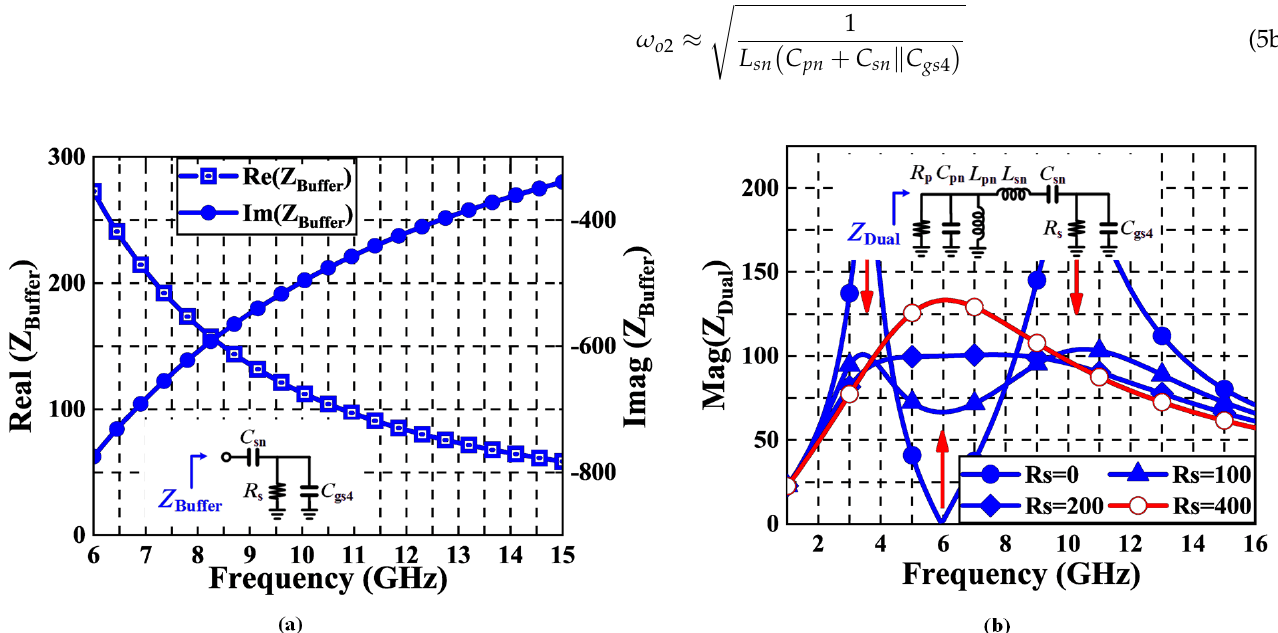
Figure 3. Dual resonant network. ( a ) simulated real and imaginary part and equivalent circuit of the output buffer; ( b ) equivalent circuit of dual resonant network and conceptual flat gain